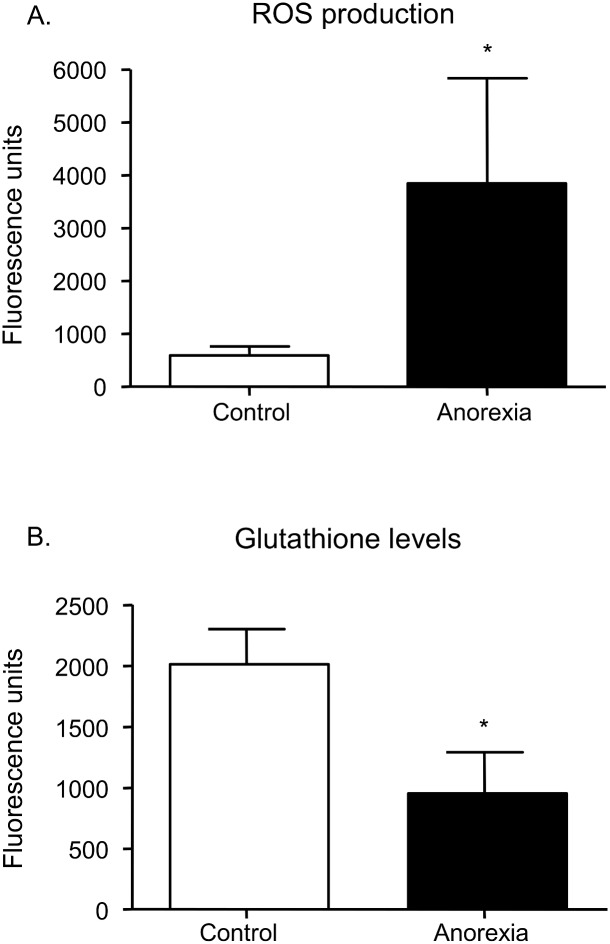
Effect of anorexia on ROS production (A), measured by DCFH fluorescence, and on GSH content (B), measured by CMFDA fluorescence.n = 20 per group. *P<0.05 vs. controls.